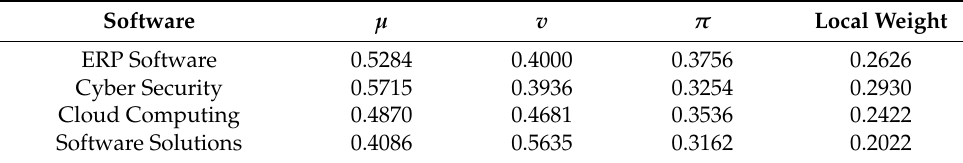
Table 6. Spherical fuzzy and defuzzified weights for sub-criteria of software.